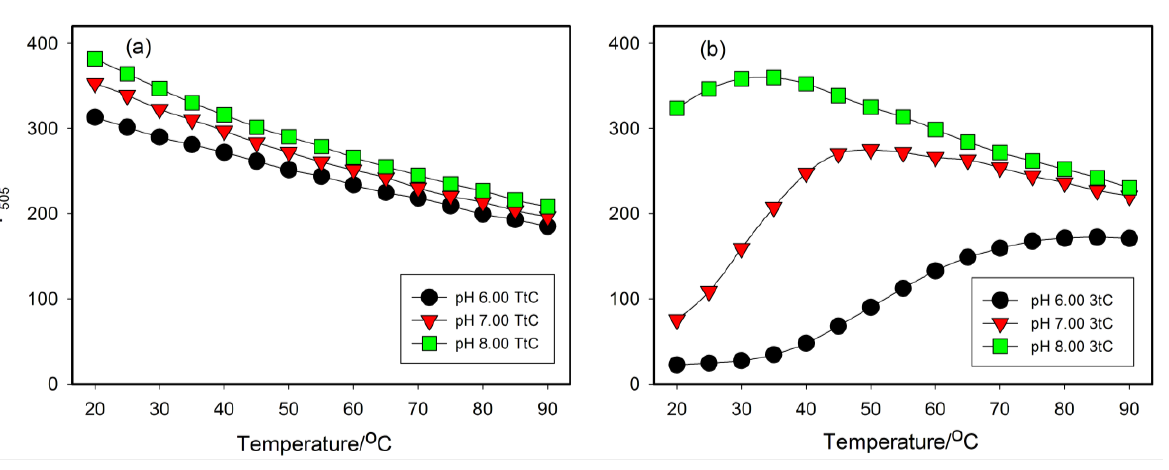
Figure 6. Temperature effect on the fluorescence intensity for TtC probe ( a ) and 3tC probe ( b ) at pH 6.00 (circles), 7.00 (triangles) and 8.00